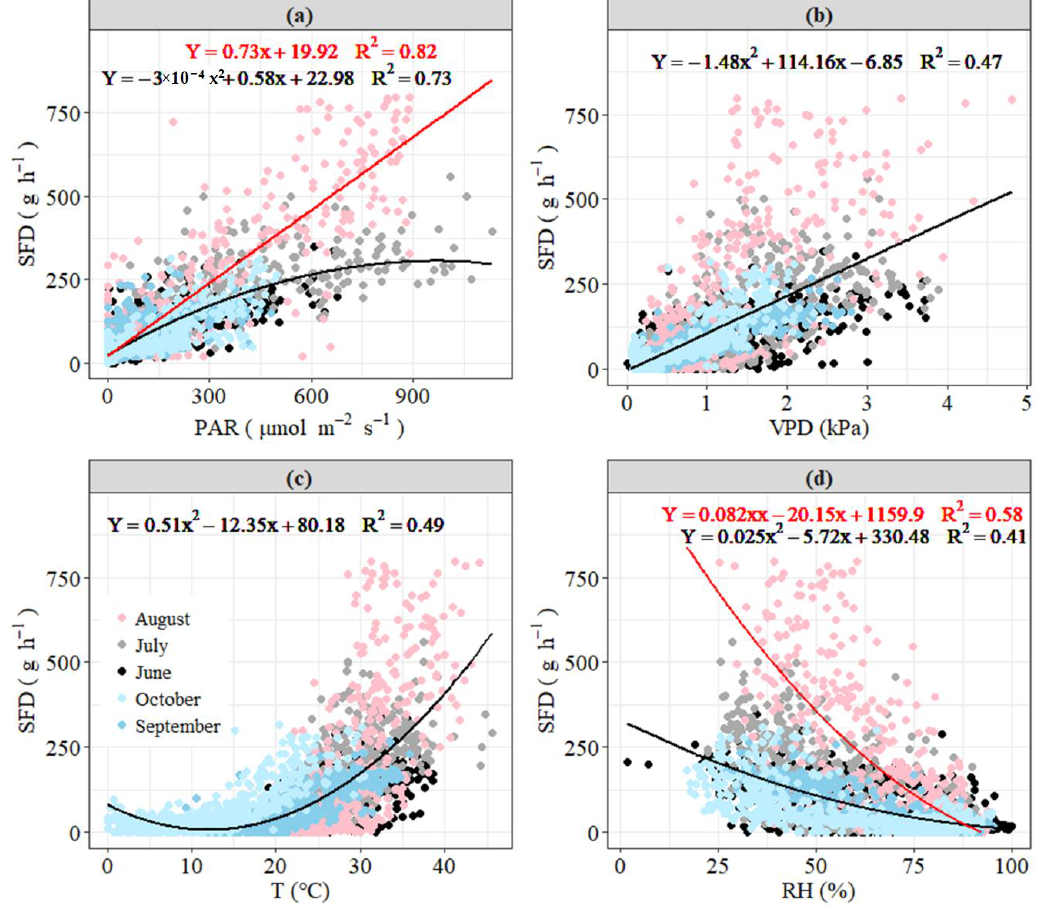
Figure 6. Plots of relationship between hourly sap flow rate (SFR) and environmental factors—( a ) photosynthetically active radiation (PAR), ( b ) vapor pressure deficit (VPD), ( c ) air temperature (T) and ( d ) relative humidity (RH) in di ff erent months in 2018. Note that the red line is the regression relationship for data in August, and the black line is that for data in other